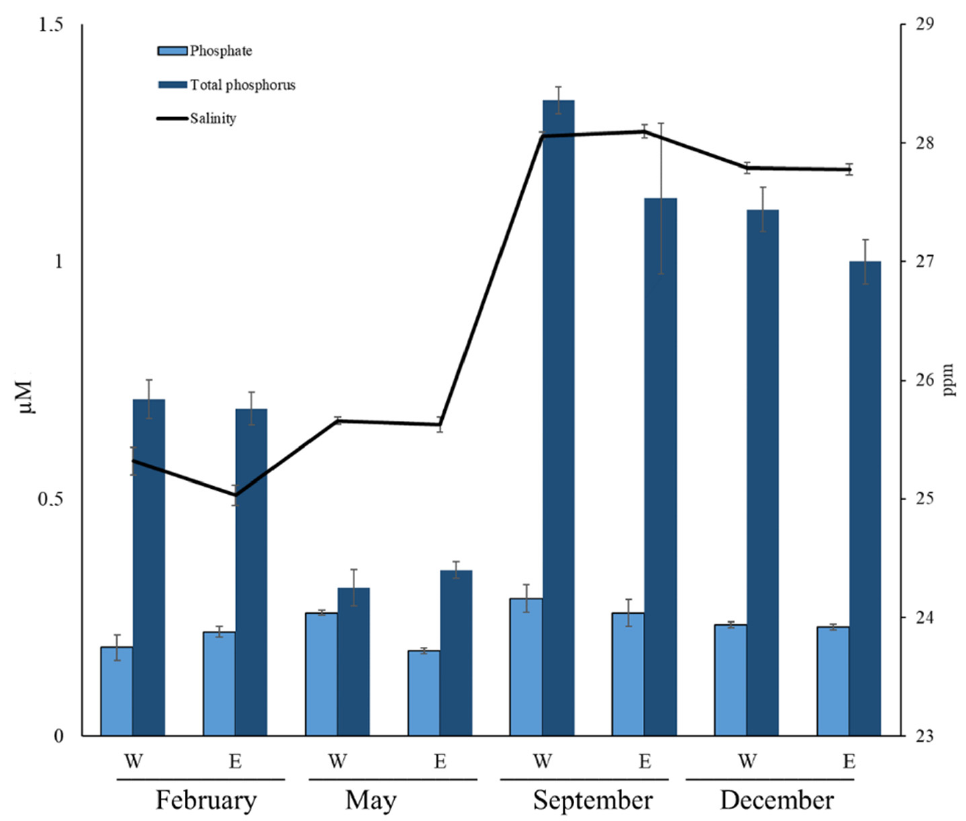
Figure 3. The seawater salinity and nutrient variables (phosphates and total phosphorus) characterizing the water column of the W and E zones during the sampling times.